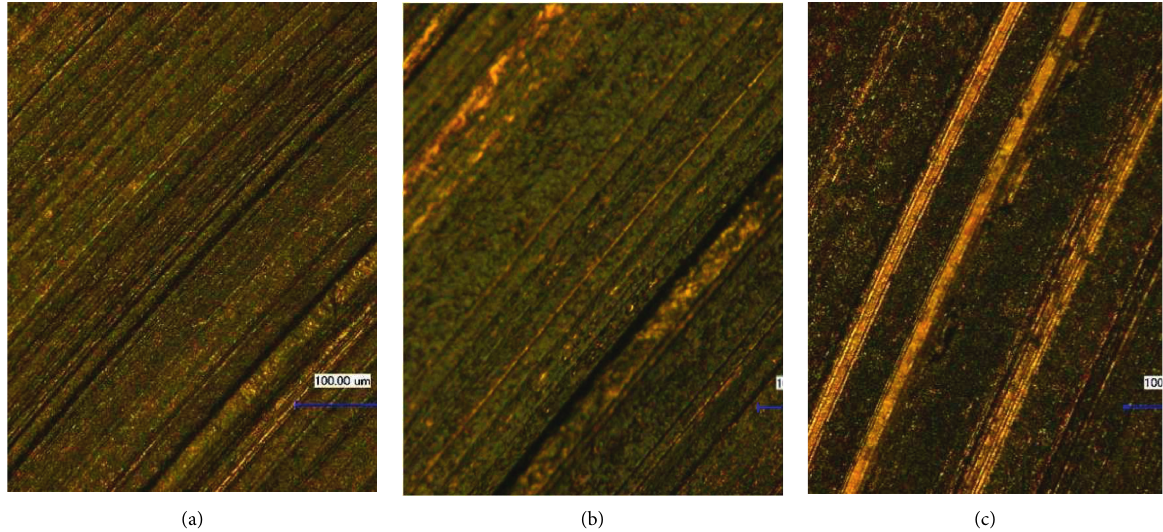
Figure 11: (a) Wear morphology of the orthogonal optimal test group. (b) Wear morphology of the parameter median group. (c) Wear morphology of the untextured sample.